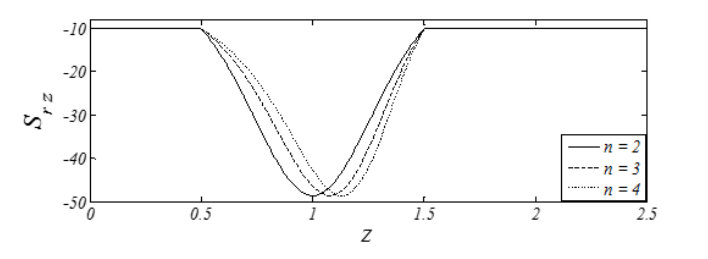
Fig. 7 Wall shear stress variation for F=1, δ =0.2, a=0.2, b=0.4, m=1.